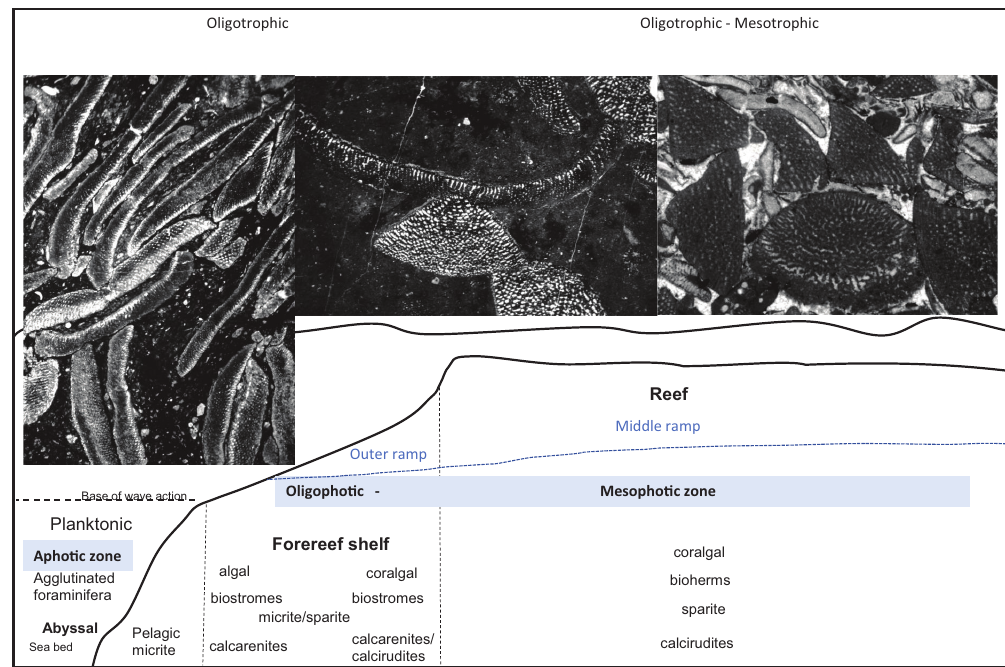
The facies range of the dominant orbitolinids in a Tethyan carbonate shelf. Integrated reef/ramp model for Cretaceous carbonates. The ramp model is indicated by the blue dotted line. In the case of gently sloping ramp, the outer ramp lithofacies are made of mudstones and wackestones, while in the middle ramp mudstone with carbonate nodules would develop. Orbitolinid photos are from the Langhan Formation, Tibet (see